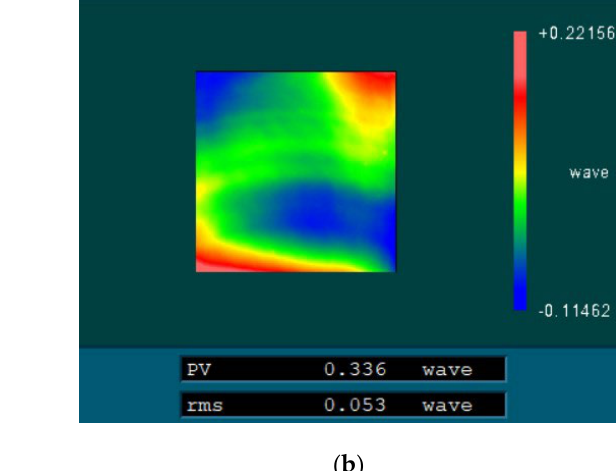
Figure 11. Surface-shape error results before and after magnetorheological polishing repair. ( a ) Surface-shape Error of Initial Components; ( b ) Surface-shape Error of Components after Magne- torheological Repair.